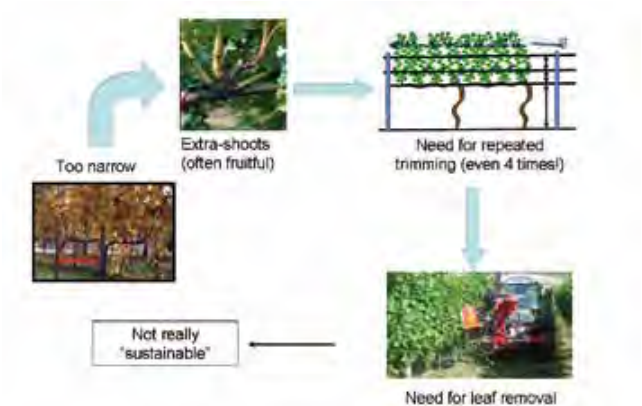
Fig. 1 - Interrelationships of excessive shoot vigour stimulated by a too narrow within-row vine spacing and related consequences on summer pruning needs (drawn by